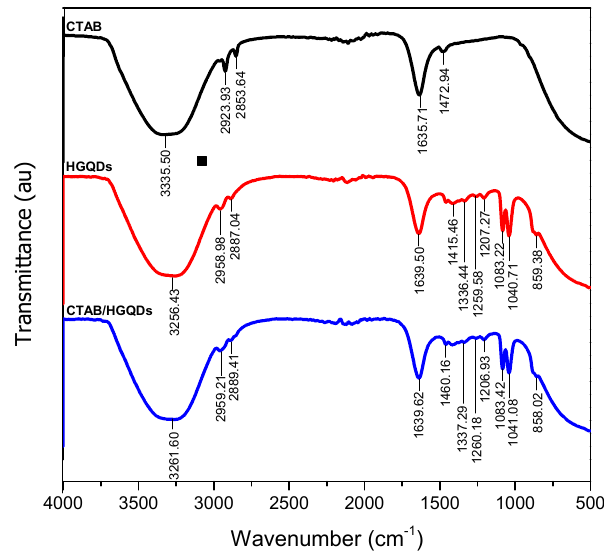
Figure 4. The combined Fourier transform infrared (FTIR) spectrum of the CTAB, HGQDs, and CTAB/HGQDs thin films.